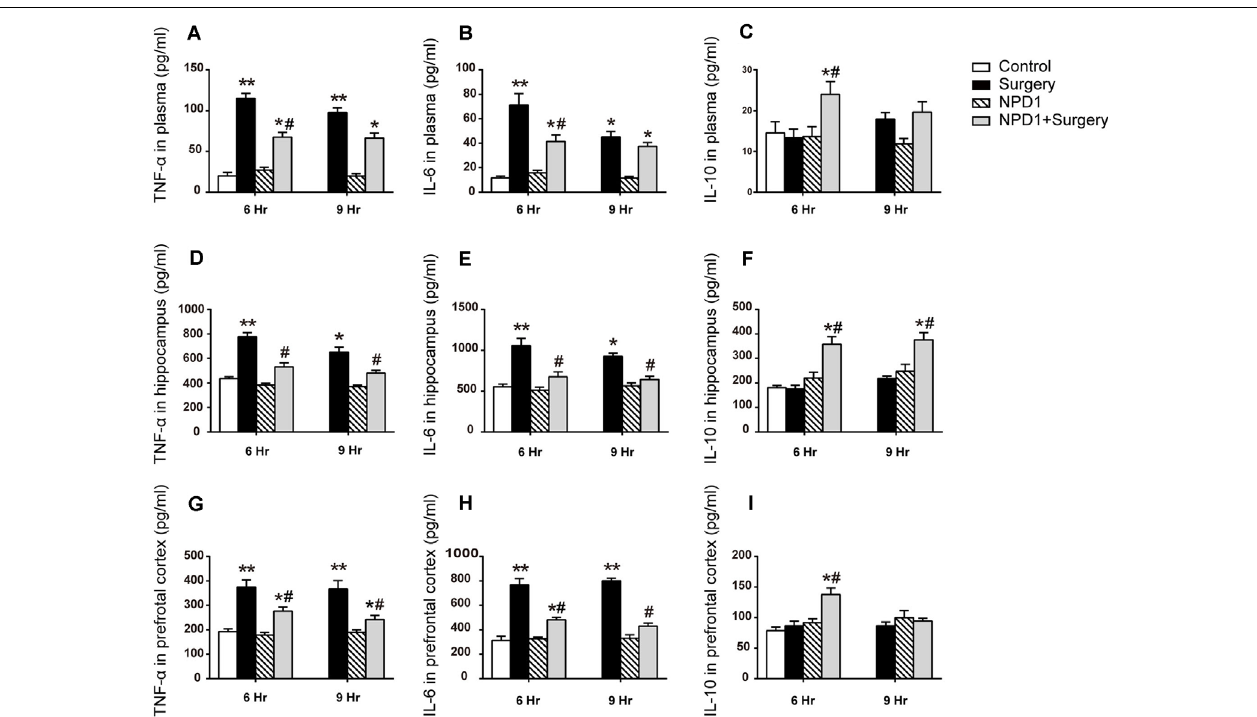
FIGURE 2 | Effects of NPD1 on the expression of inflammatory cytokines in vivo . NPD1 pretreatment alleviated the surgery-induced upregulation of pro-inflammatory factors and promoted the expression of anti-inflammatory factors both in the peripheral blood and the central locations such as the hippocampus and prefrontal cortex at different time points (A–I) . The cytokines in peripheral blood and brain tissues were measured by enzyme-linked immunosorbent assay (ELISA). Data are presented as mean ± SEM. Statistics: two-way ANOVA followed by Bonferroni post hoc comparison. (A–I) n = 4–5 per group. * P < 0.05 vs. the control group, ** P < 0.01 vs. the control group, # P < 0.05 vs. the surgery